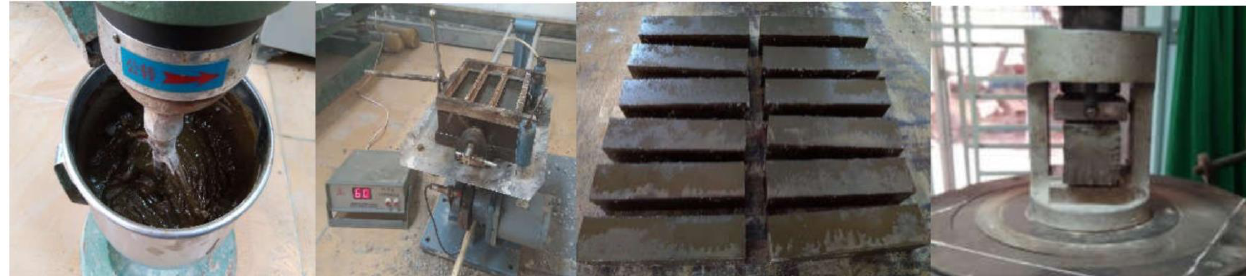
Figure 6. Confection and testing of geopolymer mortar/paste specimens.